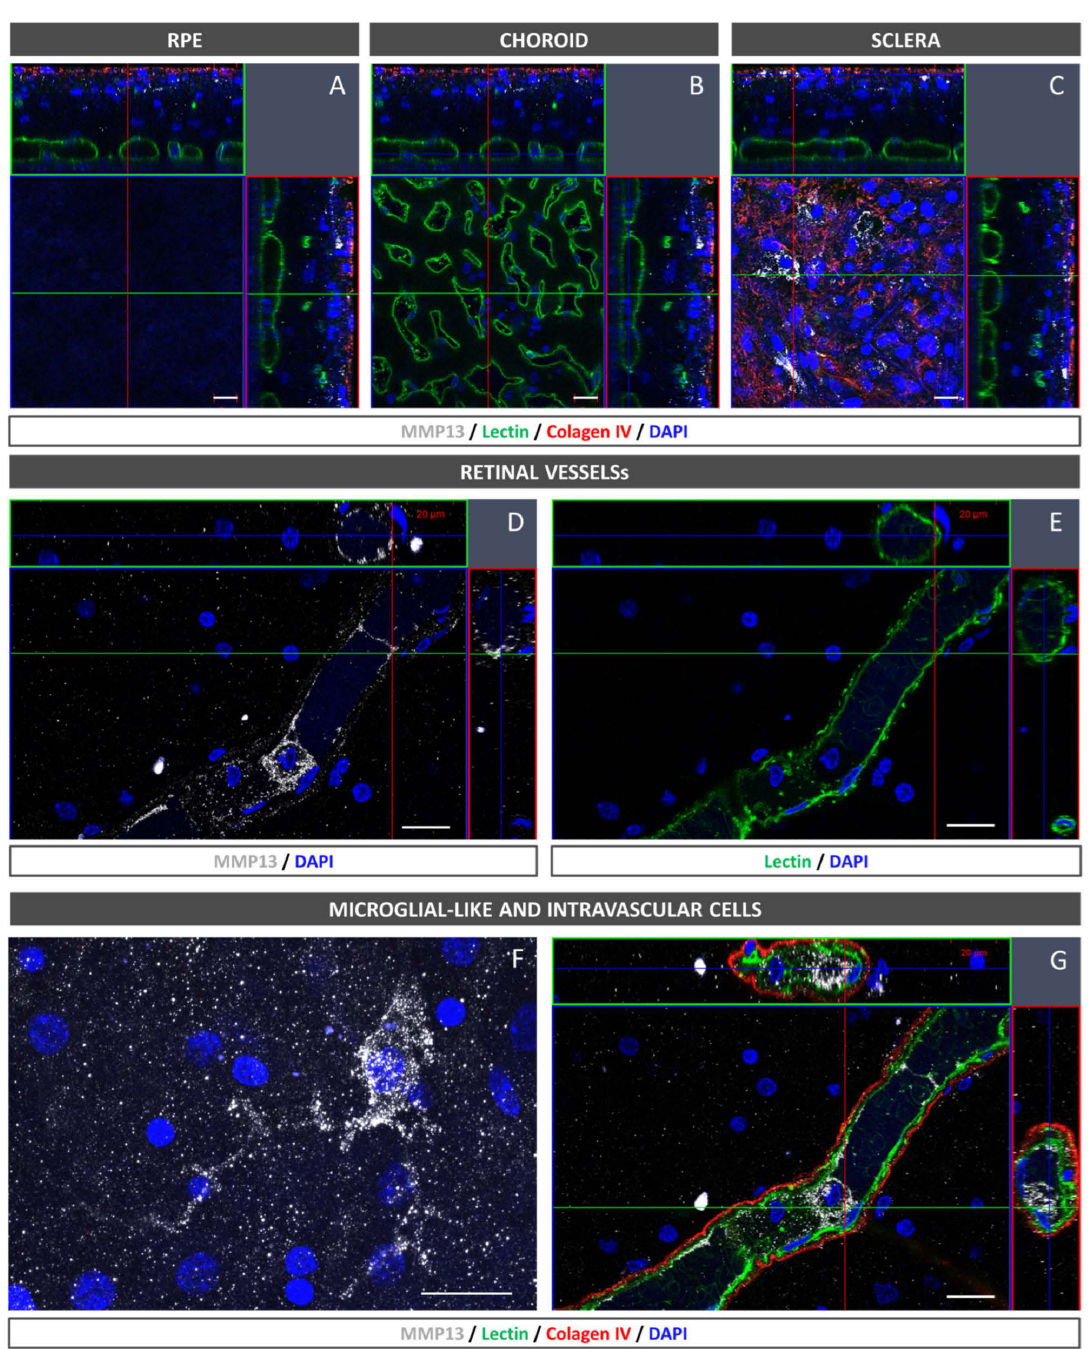
Figure 7. MMP13 immunofluorescence characterization in the human posterior pole. ( A ) The RPE and ( B ) the choriocapillaris did not show MMP13 expression. ( C ) Some cells located in the inner part of the sclera expressed MMP13. ( D ) Retinal vessels showed MMP13 expression, as observed in the z-stack cross-section of the vessel. ( E ) Lectin-positive endothelial cells colocalized with MMP13. ( F ) Some retinal parenchymal cells, predominantly in inner retinal layers, showed a marked MMP13 signal. Some of these cells showed a microglial-like activated morphology. ( G ) MMP13-positive cells were also observed in the lumen of the vessels. n = 3. MMP13, white; lectin, green; collagen IV, red; and DAPI, blue. MMP13 = matrix metalloproteinase 13. ON = optic nerve. RPE = retinal pigment epithelium. Scale bars: 20 µ